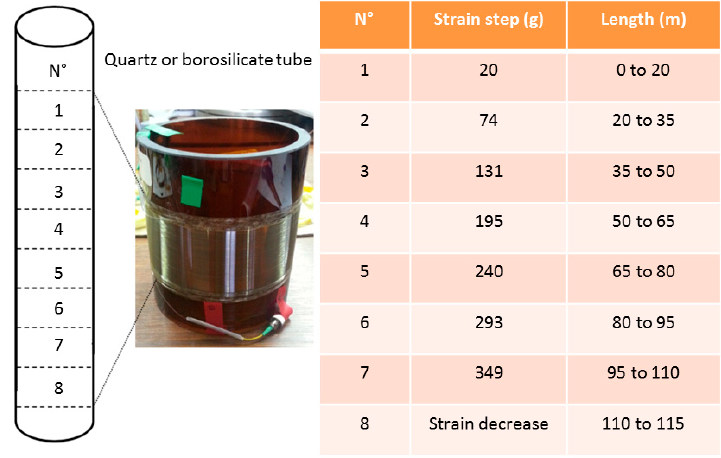
Figure 7. Schematic representation of the fibre coiling and picture of fibre sample strain steps. Borosilicate holder darkened under irradiation.